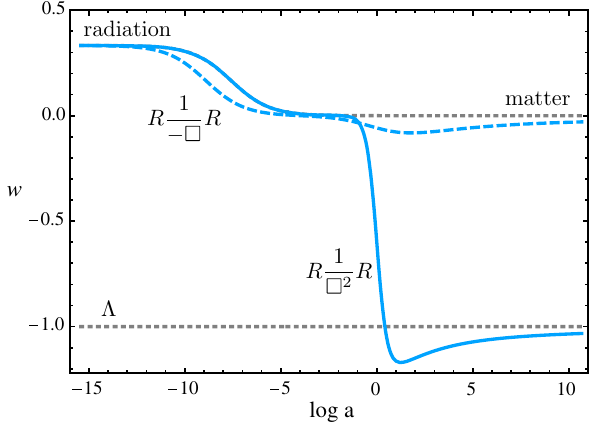
Fig. 2 We plot the total equation of state parameter w vs. log a from radiation epoch until today. The imprints due to the first two non-local R in the effective action are compared. It is terms R 1 − (cid:2) R and R 1 (cid:2) 2 R effectively leads to w (cid:8) − 1 at the present epoch evident that R 1 (cid:2) 2 taken on the right hand side of the EOM as an effective dark energy density. In Fig. 2, we have plotted the total equa- tion of state parameter w as a function of log a . It is evi- dent from the figure that the universe starting from radiation epoch ( w = 1 / 3) smoothly transits to the matter dominated regime ( w = 0) which then evolves in the present epoch dominated by the non-local term with w ≤ − 1. For later discussion we have also shown the corresponding behavior R but found that only for the leading non-local term R 1 − (cid:2) R 1 R leads to an accelerating universe today. Moreover, in (cid:2) 2 Fig. 3, we have plotted the dimensionless energy density ratio (cid:9) (cid:9) (cid:9) r , m and de as a function of log a which perfectly cor- roborates the behavior of Fig. 2. By demanding (cid:9) de (cid:8) 0 . 68 to be consistent with observations today, we can also obtain the value of the mass scale m of the non-local term to